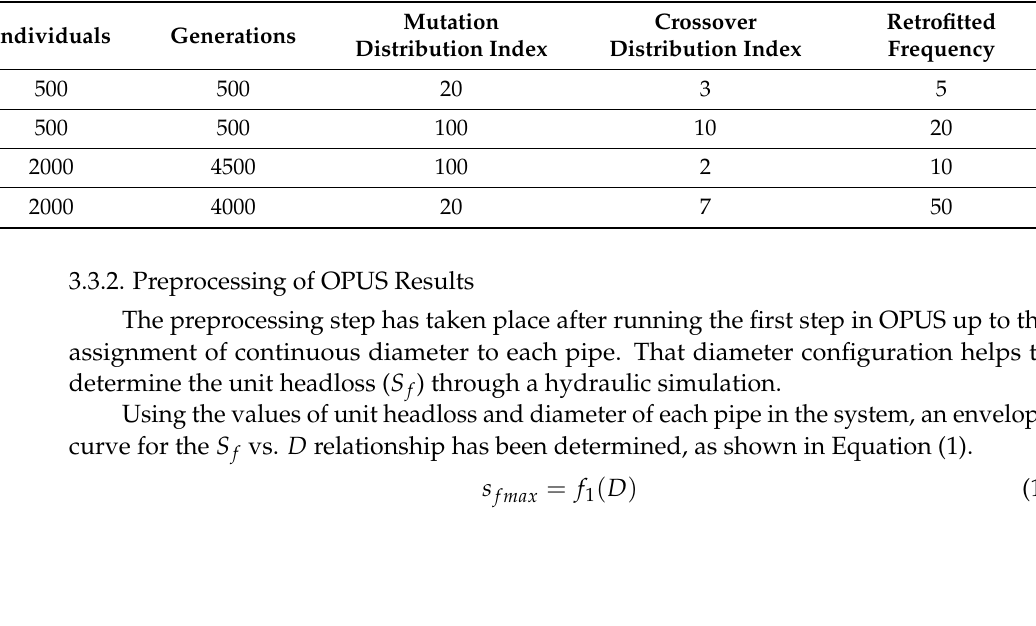
Table 1. Values of each parameter for the implementation of the NSGA-II and retrofitted approach. Source: Paez et al.